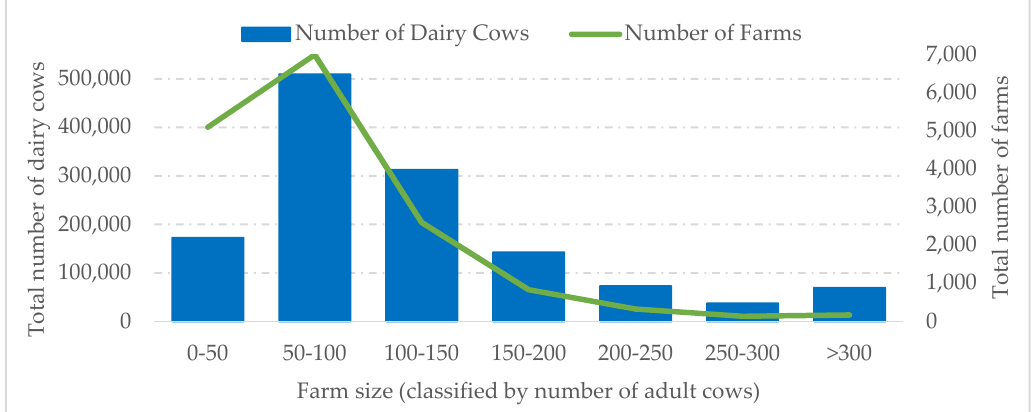
Figure 2. Distribution of total farms and dairy cows by farm size in Ireland. Estimated, based on data received from [27].